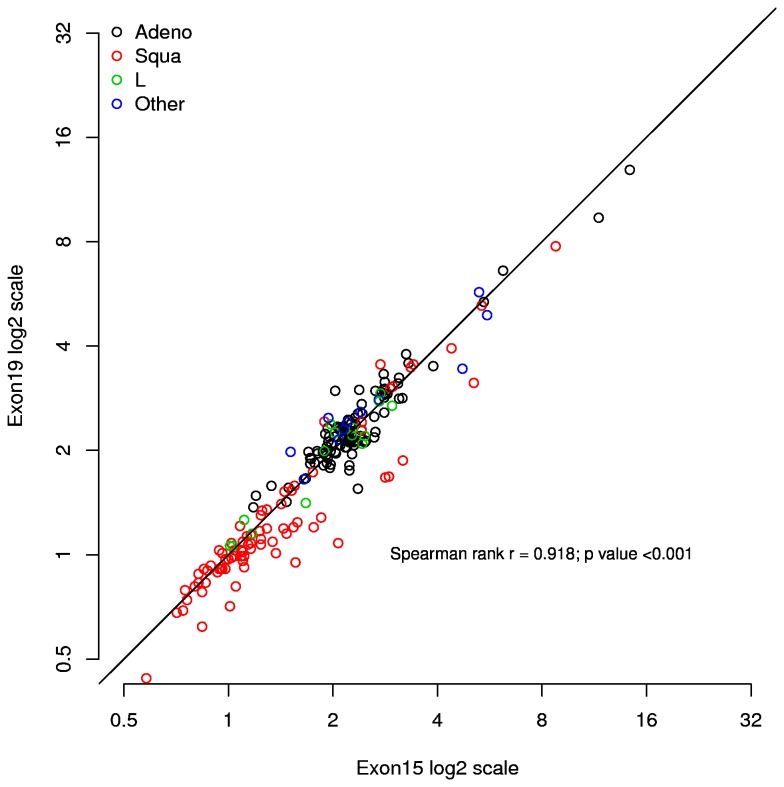
Scatter plot of exon 15 and 19 CNVs in the training cohort.